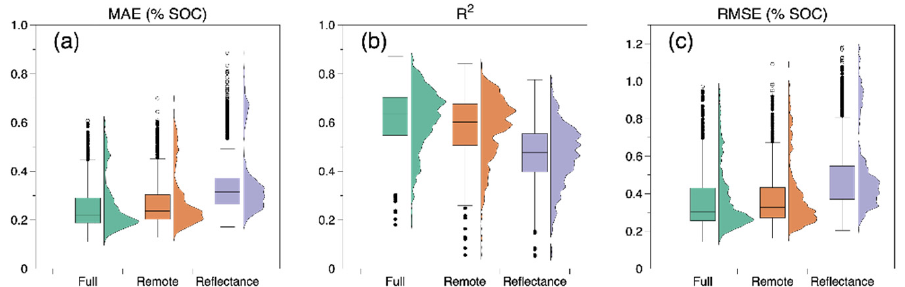
Figure 4. Model performance measured as Mean Absolute Error (MAE) ( a ), coefficient of determina- tion (R 2 ) ( b ), and Root Mean Square Error (RMSE) ( c ) across model types ( n = 1738). Raincloud plots adjacent (right) to each boxplot depict the histogram of raw data points and the frequency of different binned observations. Model bars in each boxplot represent the median value of 100 train/test splits for the corresponding model by depth combination; outer edges of the boxes represent the 25 and 75% percentiles; whiskers represent 1.5 × the interquartile range, and points represent outlying values greater than 1.5 × the interquartile range from soils collected from nineteen participating ranches encompassing approximately 17,347 ha in the Southern Great Plains ecoregion of the United States.